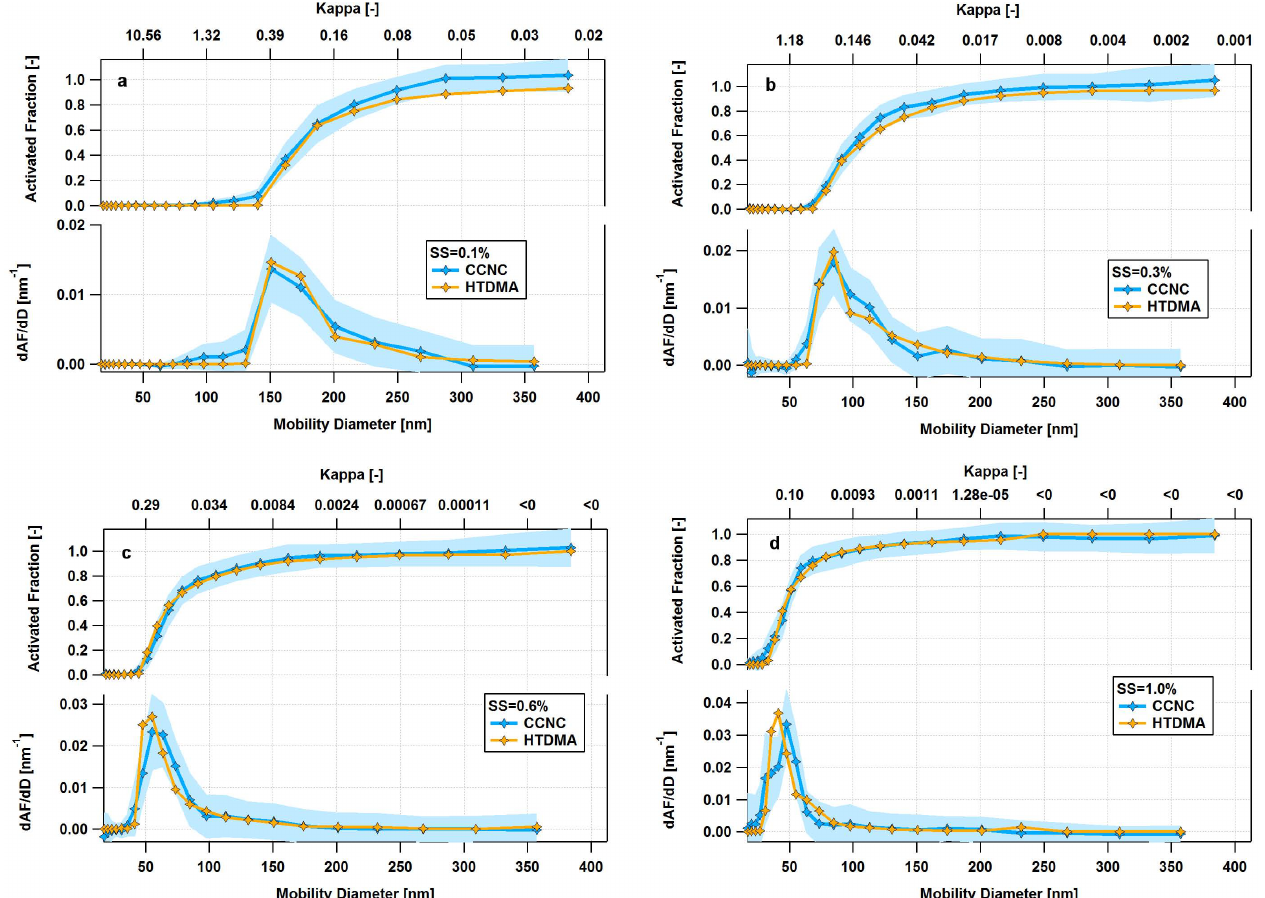
Fig. 7. Time-averaged AF( D ) and ∂ AF( D ,SS)/ ∂D as measured by the CCNC (blue markers and lines) and as derived from the HTDMA measurement (orange markers and lines) at 4 example SS (0.1, 0.3, 0.6 and 1%). The blue shading represents the standard deviation of the CCNC measurements. The top axis shows, for illustration, the κ hygroscopicity parameters that correspond to the set SS value and the dry diameter from the bottom axis; note that the κ values represent the hygroscopicity for changing dry particle